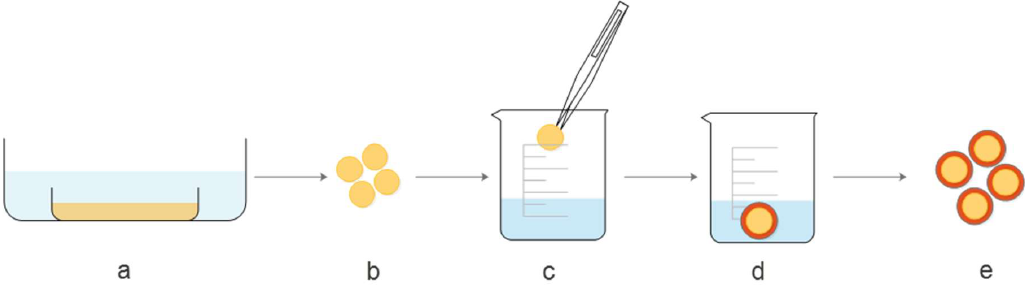
Figure 1. Schematic presentation of the coating procedure.